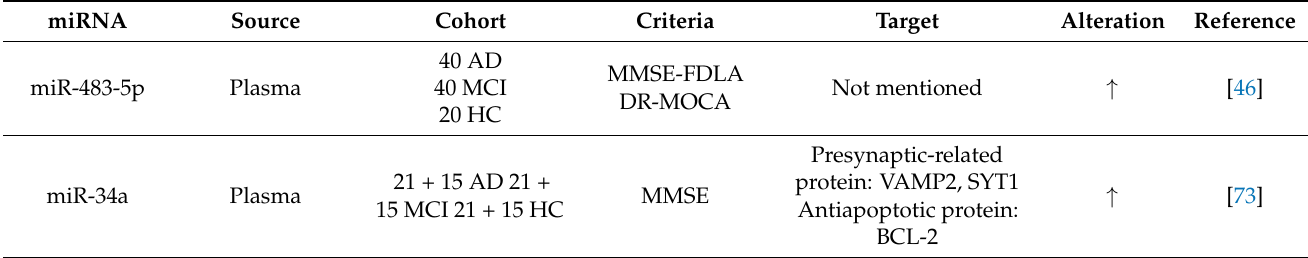
Table 1. Profile of miRNAs proposed as Alzheimer’s disease